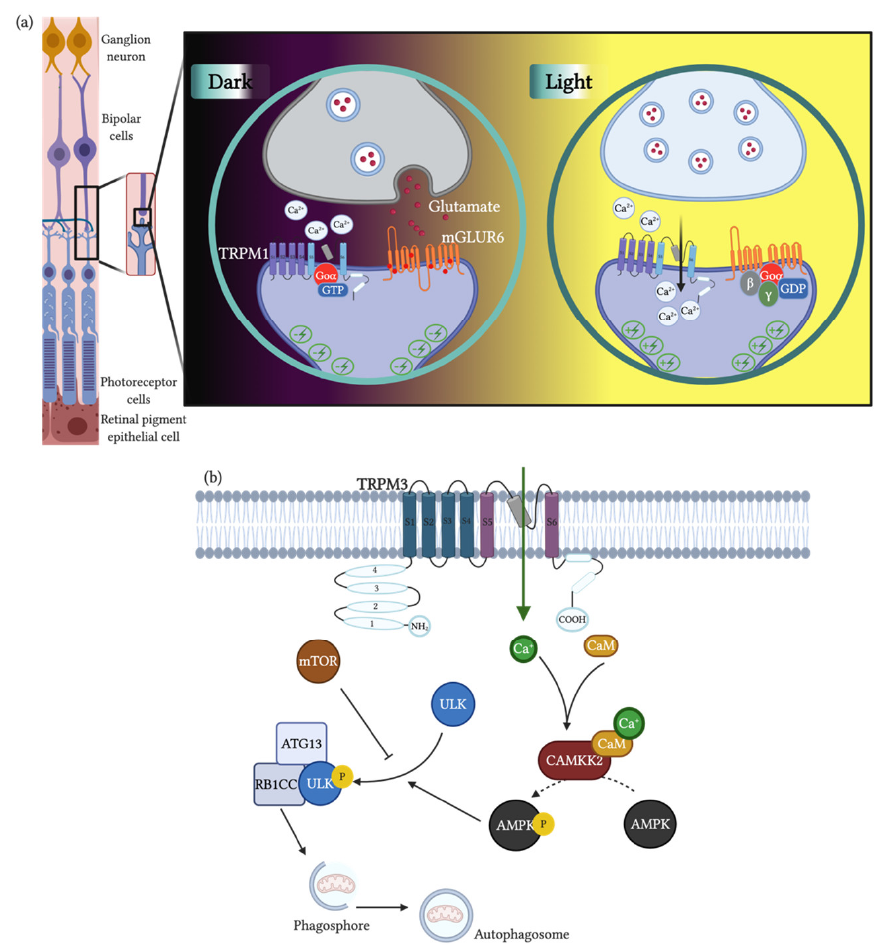
Figure 2. TRPM1 role in visual pathways. In the retina, the photoreceptors are in synaptic contact with bipolar neurons. ( a ), which in turn contact ganglion neurons, in which axons merge to form the optic nerve. In the dark, the rods secrete glutamate into the synaptic cleft, which activates the mGluR6, a G-protein coupled receptor. In its activated state, mGluR6 hyperpolarizes the neuron. In that status, G-protein Go α -GTP is bound to TRPM1, resulting in inactivation of the channel. In the presence of light, rods release low glutamate, which inactivates mGluR6. As a consequence, the dephosphorylation of GTP into GDP allows Go to bind and subunits and the complex binds mGluR6, inactivating it and avoiding hyperpolarization. The release of Go activates TRPM1, which opens, allowing calcium entry and depolarizing the bipolar neuron triggering the electrochemical signaling. ( b ) TRPM3 and autophagy in clear cell carcinoma. TRPM3 activity increases cytosolic calcium, which binds Calmodulin (CaM). Ca-CaM binds CaMKK2 and this activated complex phosphorylates AMPK. Active AMPK through phosphorylation, in turn, phosphorylates ULK, which, in its phosphorylated form, can bind ATG13 and RB1CC1. This ULK-ATG13-RB1CC1 complex allows for the formation of autophagosomes and the binding of the autophagosomes with lysosomes. ULK is normally inactive through the phosphatase activity of MTOR. Thus, in normal conditions, this pathway is inactive. Created with